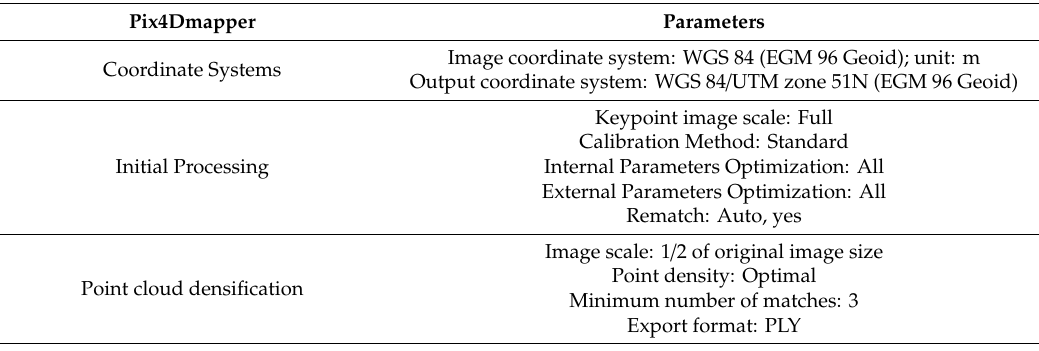
Table 2. Summary of parameters used for SfM processing in